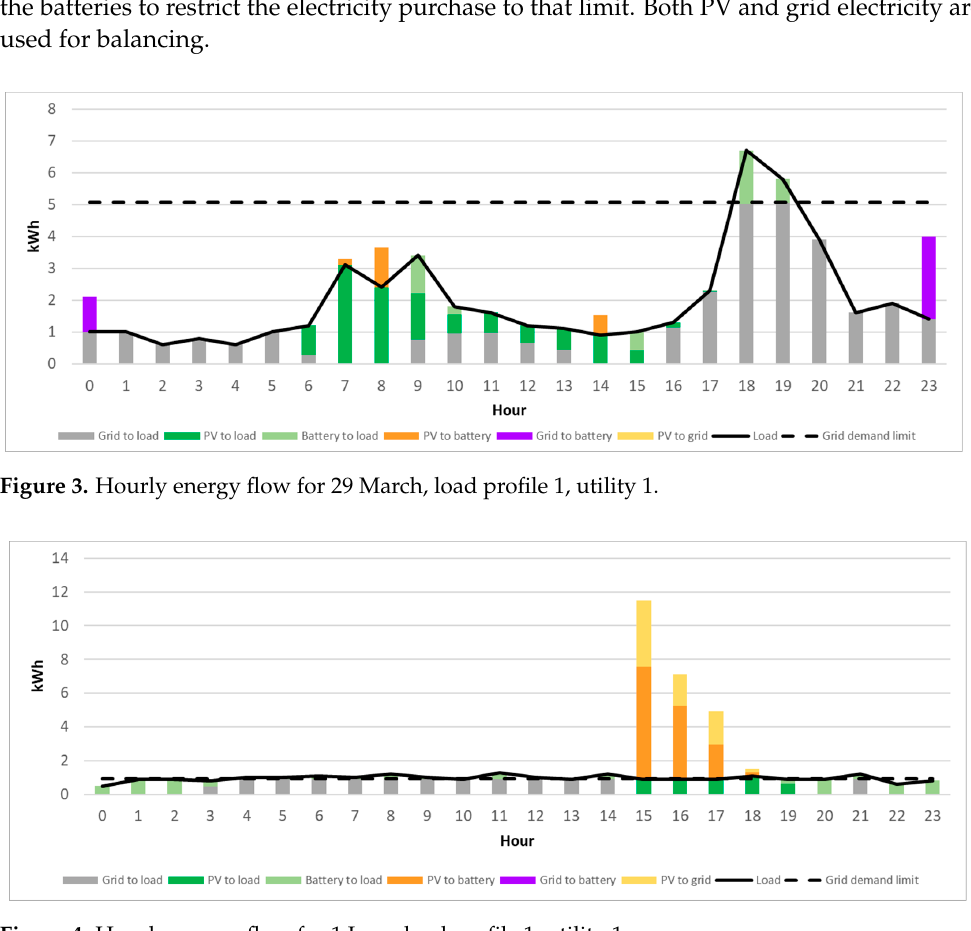
Figure 4. Hourly energy flow for 1 June, load profile 1, utility 1.